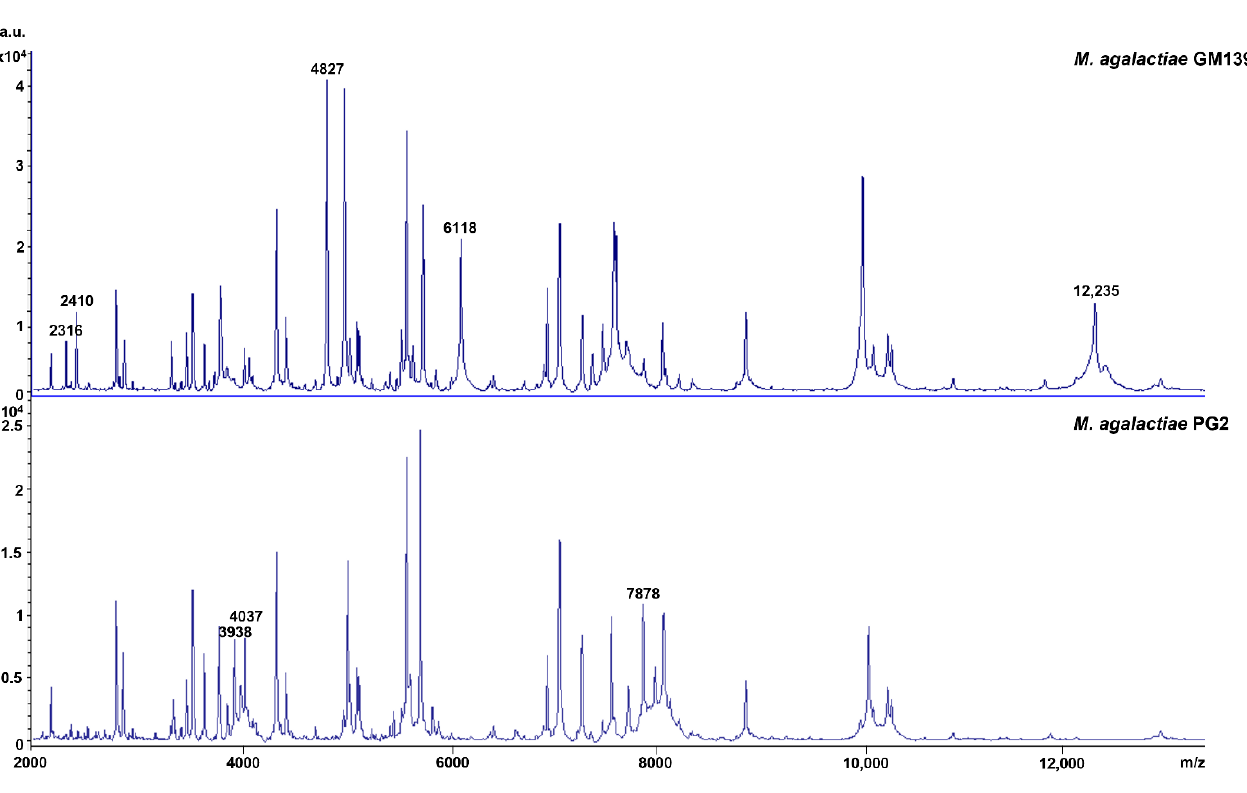
Figure 3. Peptide mass fingerprints of M. agalactiae GM139 and PG2 highlighting strain-specific peaks.